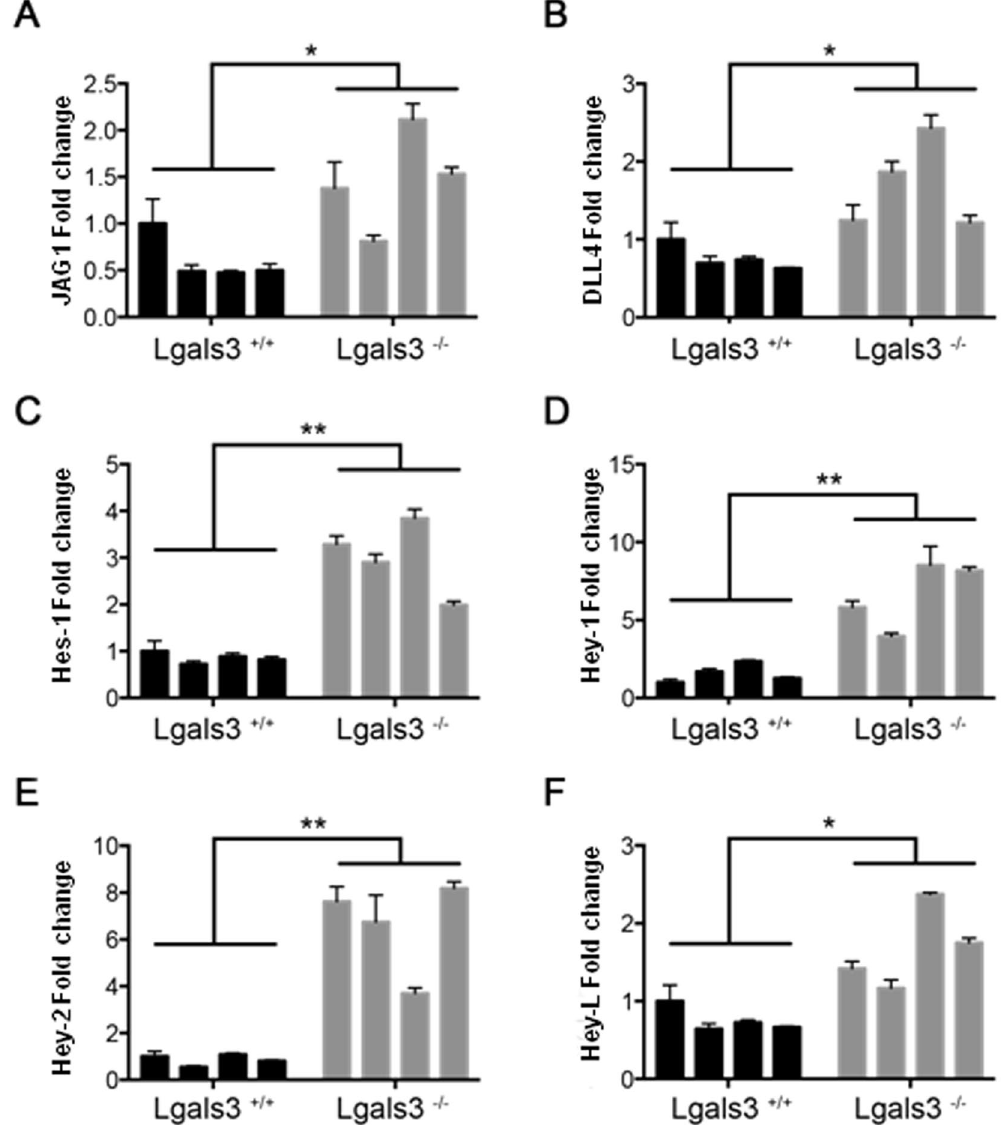
Figure 3. Notch signaling pathway in the bone marrow of Lgals3 − / − mice. Expression of the Notch signaling pathway components in total bone marrow cells of Lgals3 + / + (black bars) and Lgals3 − / − mice (gray bars). The expression levels of JAG1 ( A ) DLL4 ( B ) ligands was measured in Lgals3 + / + and Lgals3 − / − mice. Notch target transcription factors Hes-1 ( C ), Hey-1 ( D ), Hey-2 ( E ) and Hey-L ( F ) werealso evaluated in both mice groups. n = 4 mice per group. ( * ) Indicates p <